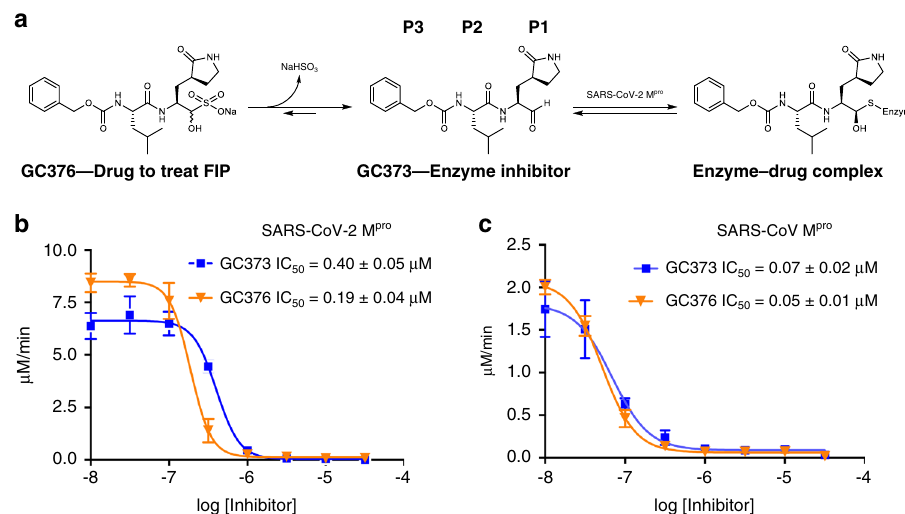
Fig. 1 M pro of SARS-CoV-2 and SARS-CoV are inhibited in vitro by GC373 and GC376. a Schematic representation of inhibitor prodrug GC376, used to treat cats of FIP, and GC373, the actual protease inhibitor. b IC 50 values for GC373 and GC376 for SARS-CoV-2 M pro and c SARS-CoV M pro cleavage of Abz-SVTLQSG-Y(NO2)-R. N = 3, values are represented as mean ±